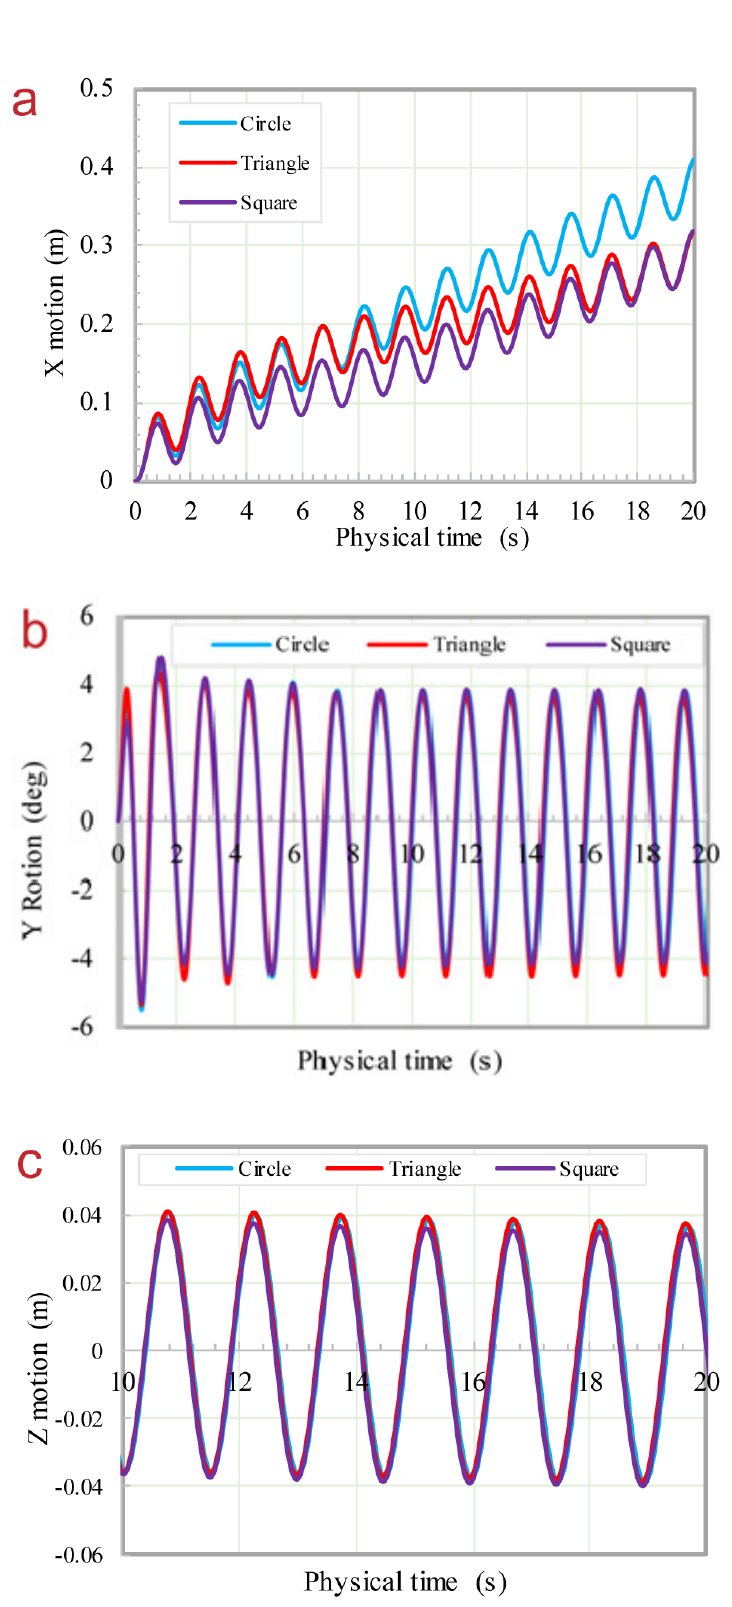
Figure 10. Motions of ice floes along x, y, and z directions in different shapes. ( a ) X motion of ice floe; ( b ) Y rotation of ice floe; ( c ) Z motion of ice floe.